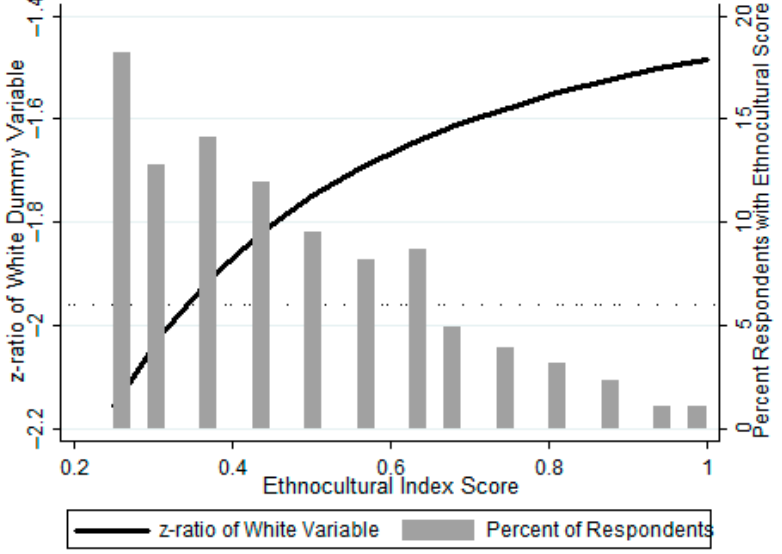
Figure 1. Conditional z-ratio for the white dummy variable.